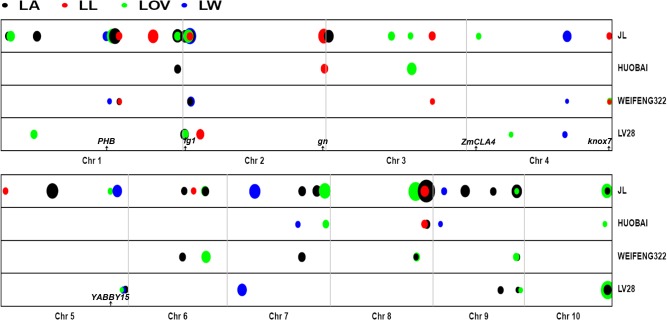
The leaf angle (LA), leaf length (LL), leaf width (LW), and leaf orientation value (LOV) QTLs obtained from single and joint-linkage QTL analyses across all the 10 chromosomes.Other parents were crossed with the HZS common parent to derive each bi-parental population as shown on the right vertical axis. The result of joint linkage mapping across the three populations is indicated as JL. The physical distance for each chromosome is represented in Mb units on the horizontal axis. Chromosomes were separated by solid gray lines. A solid circle size represents different LOD values ranging from 4.0 to 16.0. Different circle colors represent different traits. Arrows represent the physical location of the known maize leaf architecture genes overlapping with or adjacent to joint QTL.